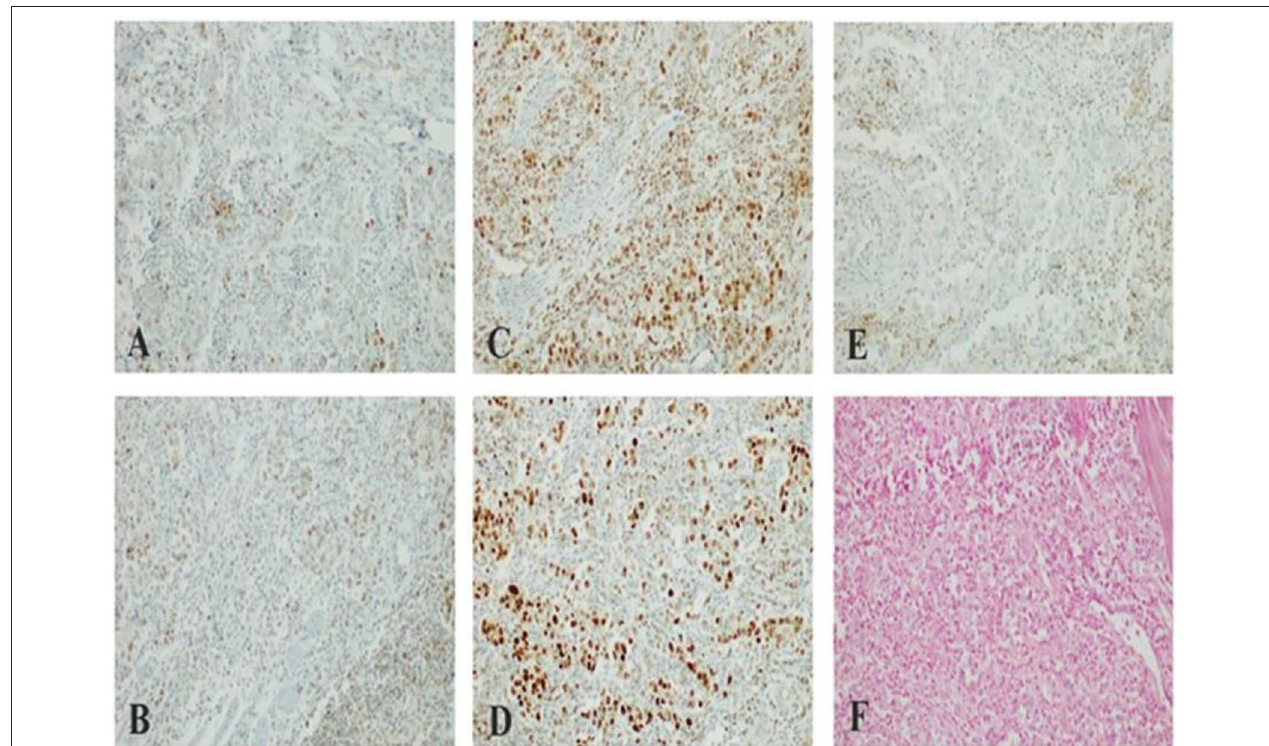
FIGURE 4 | (A,B) “Patchy” nuclear staining of MLH1/PMS2 heterodimer in large neoplastic cells with scattering nuclear positivity of Tumor-Infiltrating Lymphocytes (TILs); (C,D) preserved nuclear staining of MSH2/MSH6 heterodimer in neoplastic cells; (E) lack of membranous staining of PD-Ll in large neoplastic cells with scattering positivity of Tumor-Infiltrating Lymphocytes (TILs); (F) lack of nuclear staining of Epstein-Barr virus (EBV)-encoded small RNAs (EBERs) (Patient